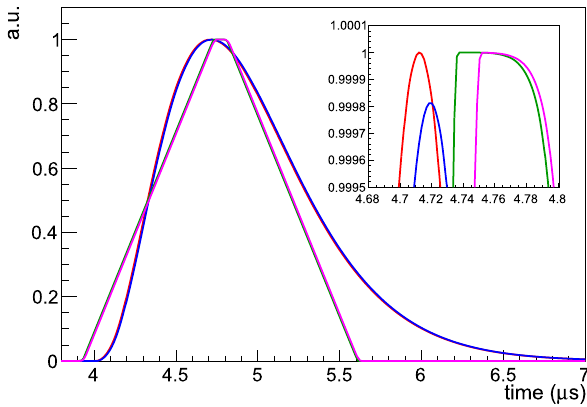
Fig. 6 The shaping filter output signals from the two simulated BEGe detector signals in Fig. 5 are shown in this plot, with the SSE (MSE) output signal reported in red (blue) and green (violet) for the case of trapezoidal and semi-gaussian WFs,